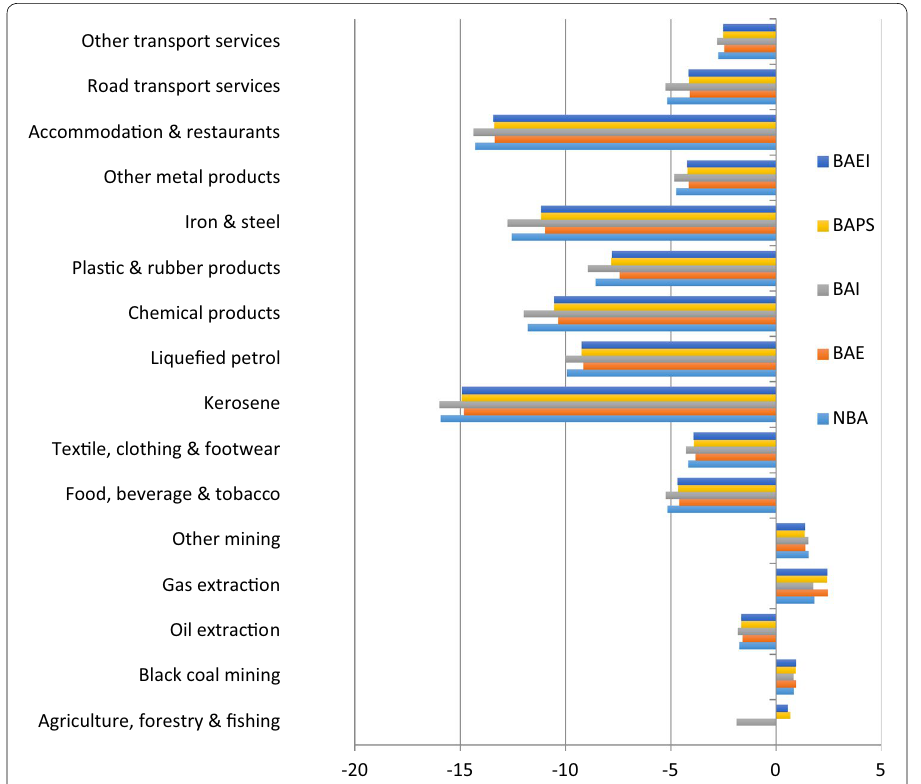
Fig. 5 Percentage change in export volumes by sector. Source Model